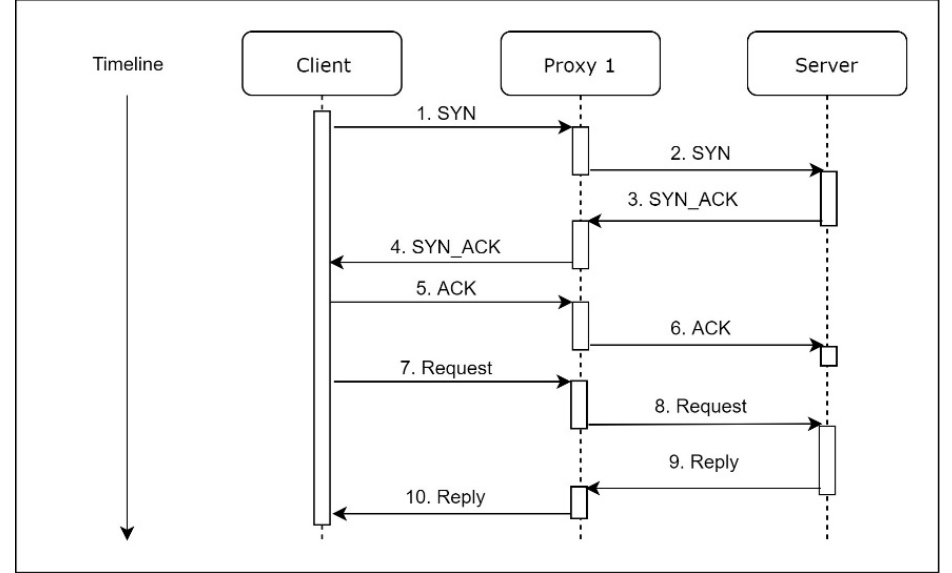
Figure 2. Moving Virtual Machine ( MVM) workflow under normal conditions.